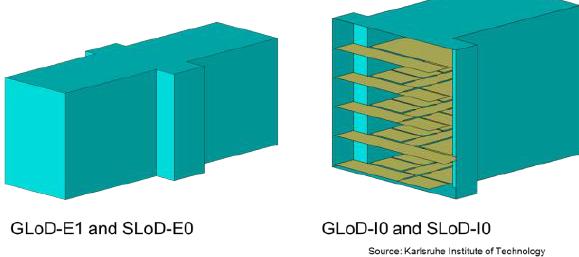
Figure 13: Building exterior as GLoD-E1 solid and interior as GLoD-I0 surface